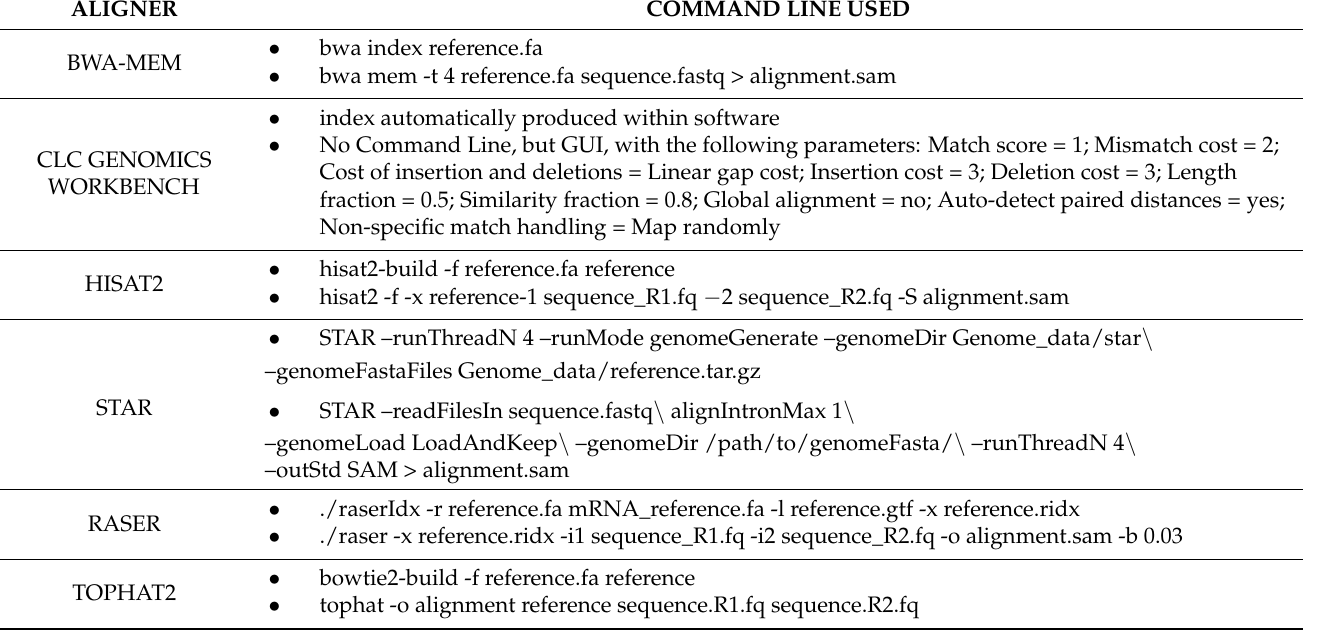
Table 1. Aligner parameters used in the analysis. The first point refers to genome indexing creation, while the second to the read mapping task. All other arguments are set to default if not specified. reference.fa = reference genome in FASTA format. sequence_R1.fq and sequence_R2.fq = input paired-end